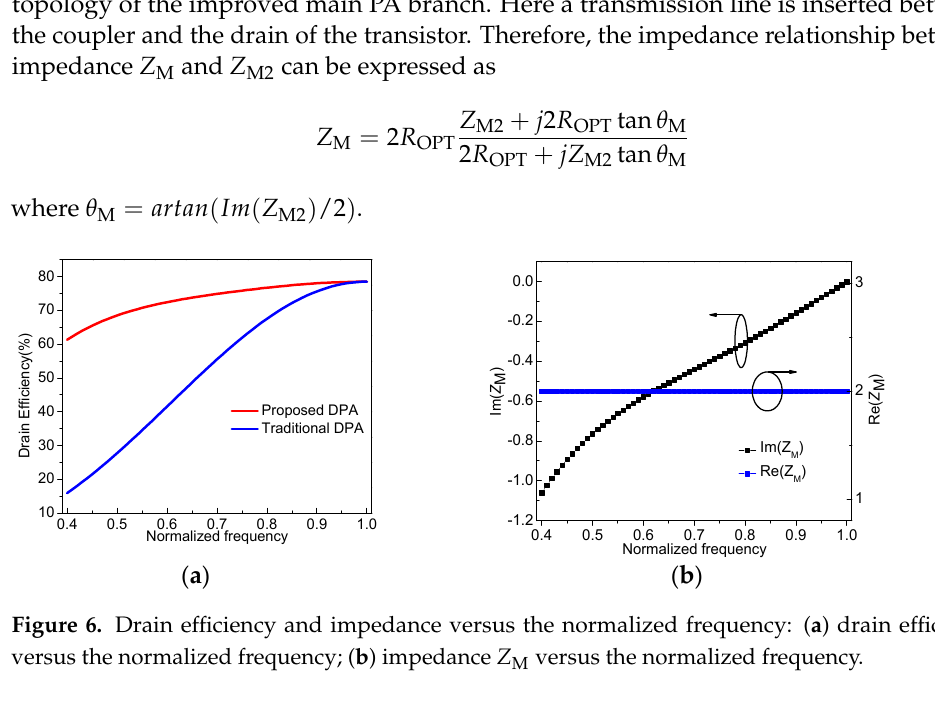
Figure 6. Drain efficiency and impedance versus the normalized frequency: ( a ) drain efficiency versus the normalized frequency; ( b ) impedance Z M versus the normalized frequency.